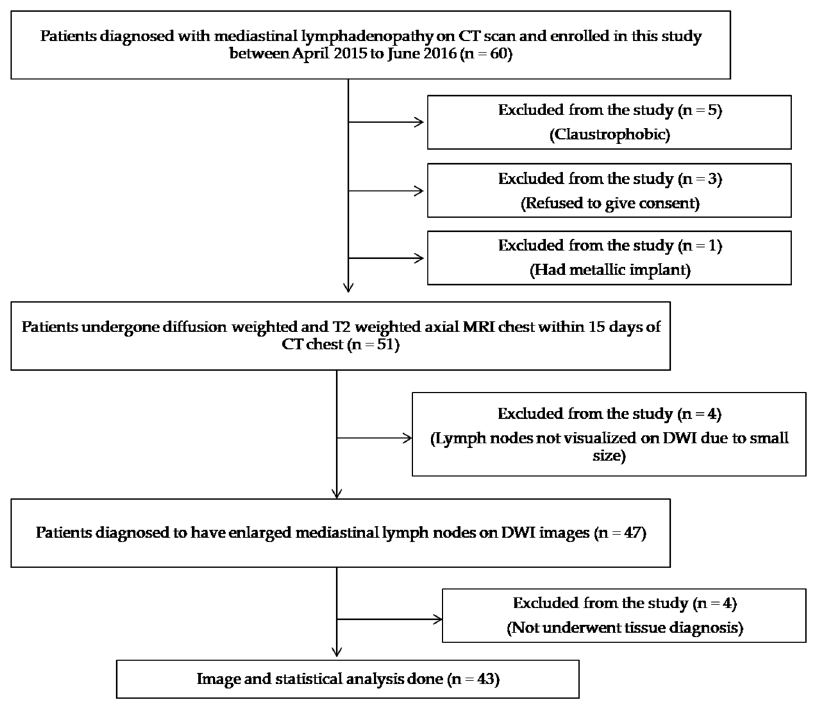
Figure 1. Flow diagram depicting the recruitment process of the study cohort. [CT—Computed tomography, DWI—diffusion-weighted imaging].